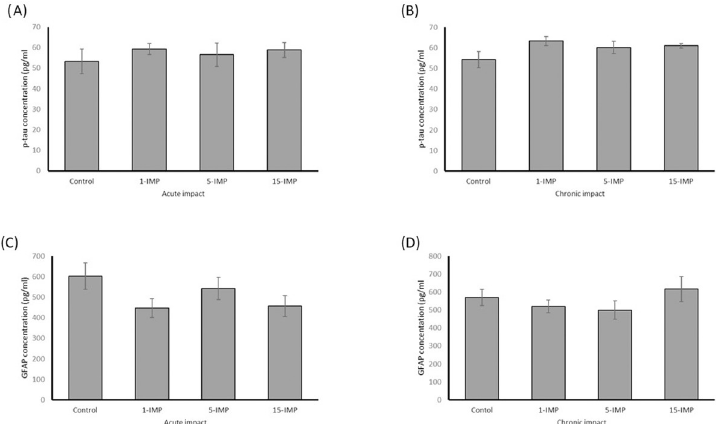
Fig 7. Repetitive mTBI does not affect p-tau or GFAP protein expression in our model. (A) P-tau serum protein expression at acute testing. (B) P-tau serum protein expression at chronic testing. (C) GFAP serum protein expression at acute testing. (D) GFAP serum protein expression at chronic testing. No significant differences were seen between any groups. N = 4 per group.